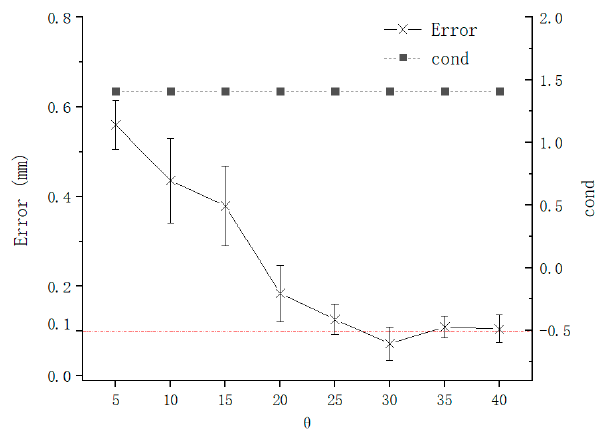
Figure 14. Error of TCPP with θ .